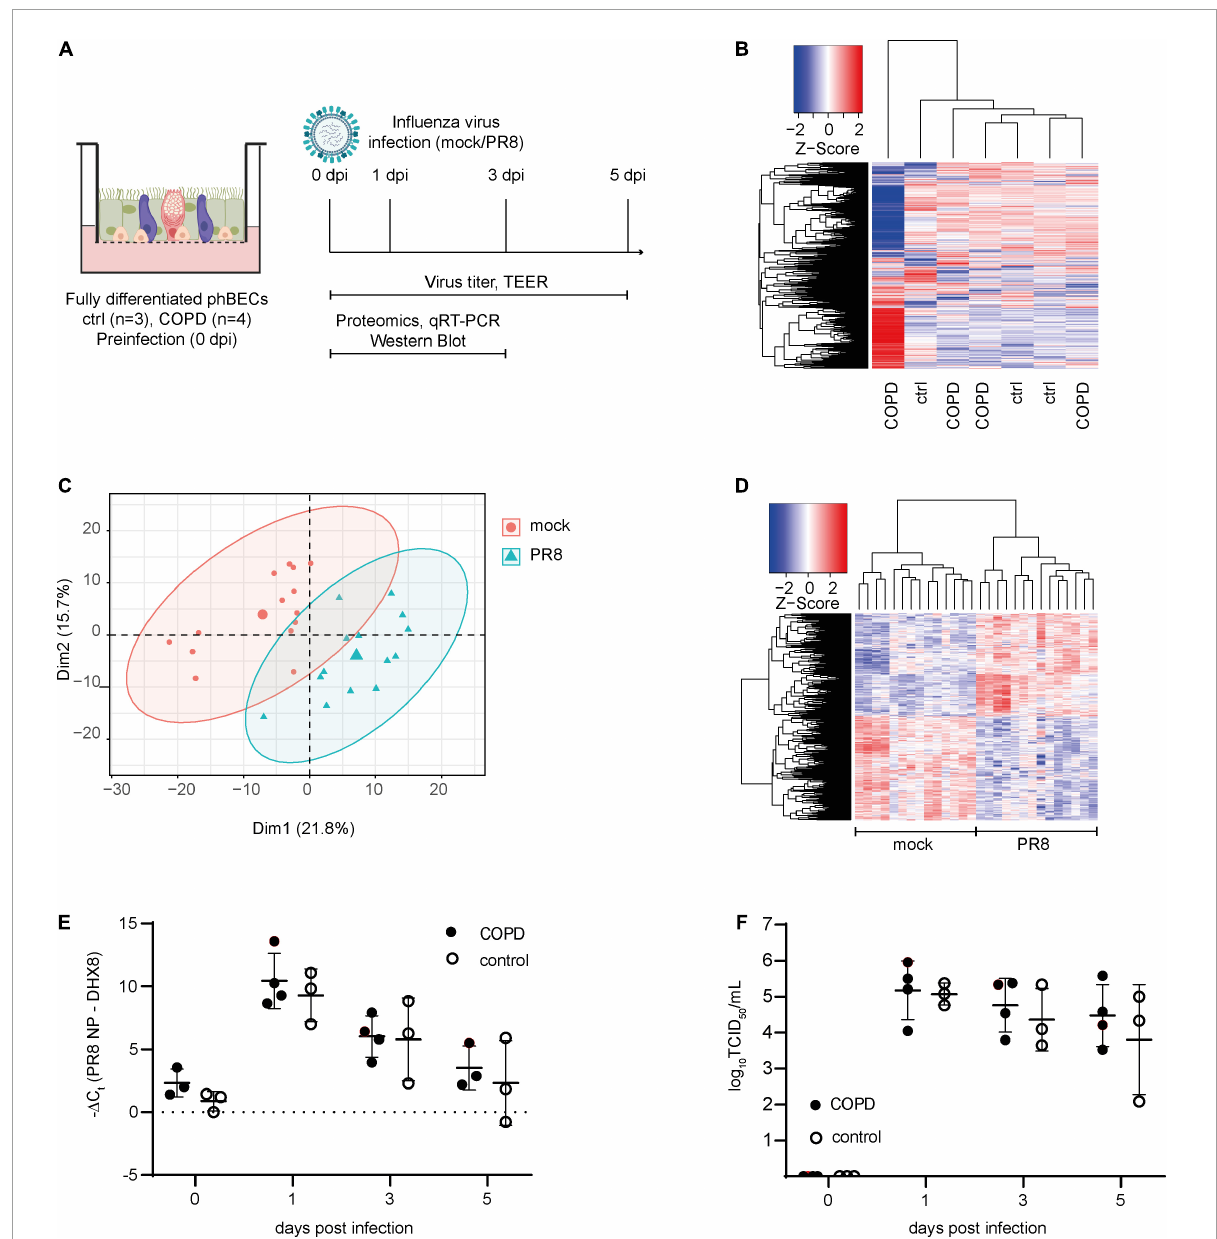
FIGURE2 Proteomics pre- and post-influenza virus infection in fully differentiated primary human bronchial epithelial cells (phBECs). PhBECs from patients with chronic obstructive pulmonary disease (COPD) ( n = 4) and controls ( n = 3) were differentiated for 28 days at the air–liquid interface and either mock-infected or infected with influenza A virus PR8. Cells were harvested for proteomics on day 28 after airlift (pre-infection), and on days 1 and 3 post-infection. To examine viral replication, cells and apical washes were harvested on day 0 (after incubating the cells with the virus to allow attachment, and after removing the unattached virus by washing) and on days 1, 3, and 5 post-infection. (A) Scheme of culture, infection, and sample analysis. An illustration was created with biorender.com. TEER, transepithelial electrical resistance. (B) Heatmap of proteomics pre-infection. The protein profile of the COPD GOLD stage IV-derived phBECs is shown in the outermost left lane. (C) Principal component analysis of proteomics post-infection. (D) Heatmap of significantly altered proteins post-infection with all patients/controls and all time points (PR8 vs. mock, n = 7). A protein was considered to be differentially expressed if the comparison resulted in a false discovery rate (FDR) of less than 5% with the Benjamini–Hochberg (BH) correction to correct multiple testing. (E) Total RNA was extracted from cells and mRNA levels of PR8 nucleoprotein transcripts were examined by RT-qPCR. DHX8 was used as a housekeeping gene. (F) Infectious viral particles in apical washes were quantified by an end point dilution assay. TCID 50 : 50% tissue culture infectious dose. For panels (E,F) , statistical analysis was performed using an unpaired, two-sided Mann–Whitney U test, but with a cutoff point of p < 0.05, no statistically significant differences were